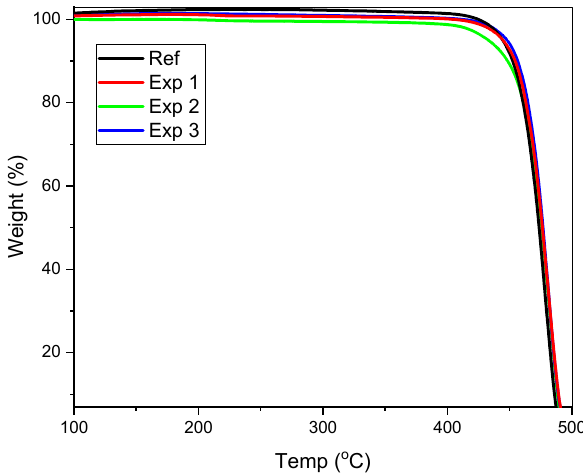
Figure 7. Thermograms for virgin and aged samples.